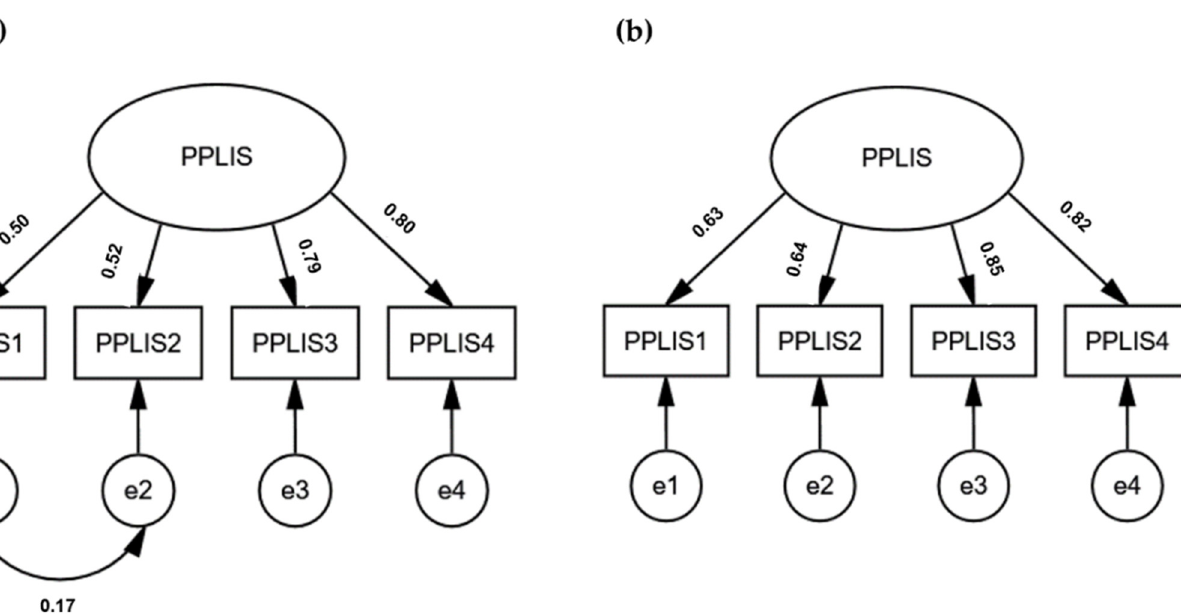
Figure 1. Results of Confirmatory Factor Analysis for ( a ) Sample 2 and ( b ) Sample 3. PPLIS = Perceived Positive Lockdown Impact Scale. Numbers by arrows represent standardized loading weights ( β ); e1–e4 = error variance.